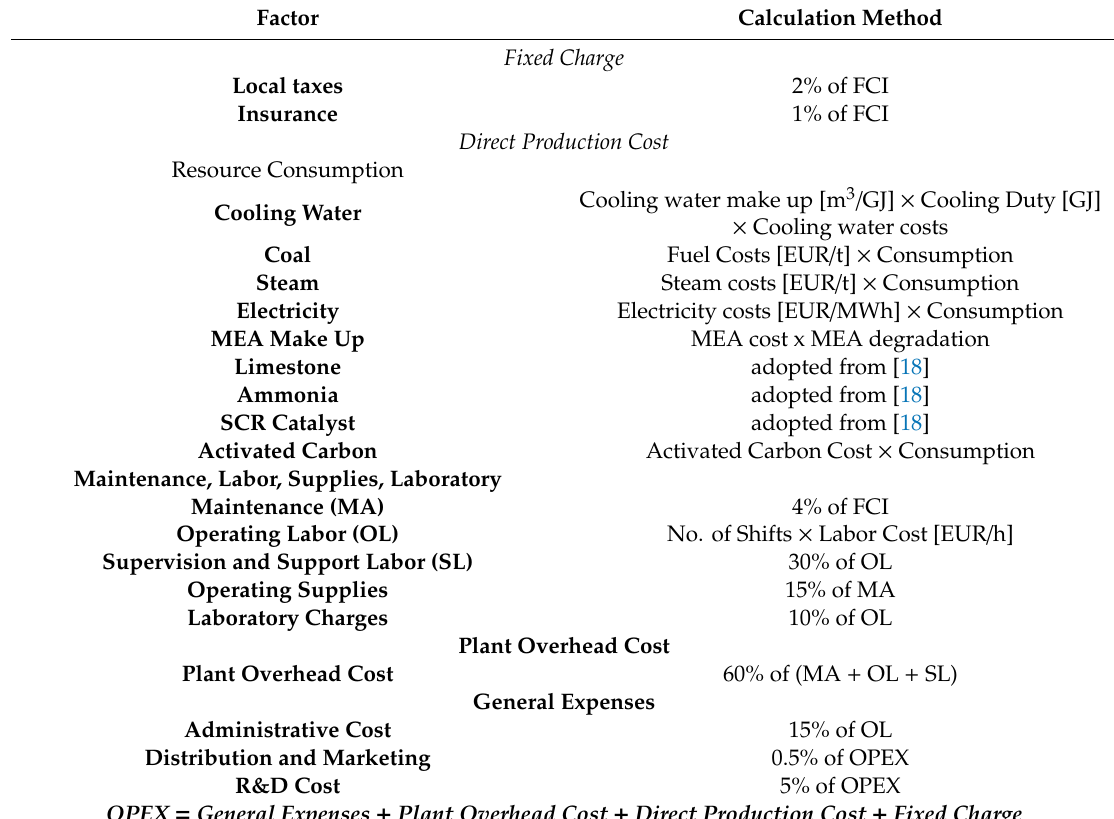
Table A8. OPEX calculation and cost factors from the literature